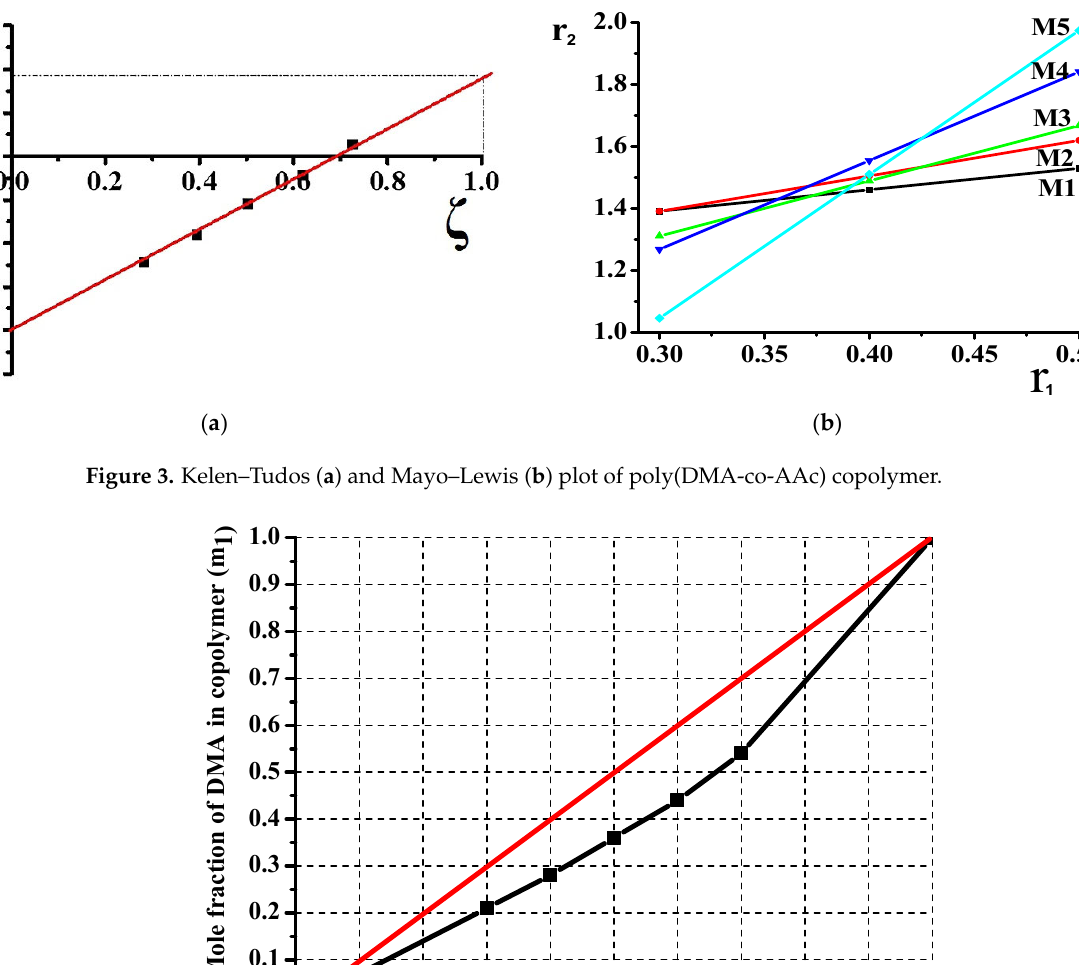
Figure 3. Kelen–Tudos ( a ) and Mayo–Lewis ( b ) plot of poly(DMA ‐ co ‐ AAc) copolymer. Table 2. Copolymer constants based on Fineman–Ross, inverted Fineman–Ross, Kelen–Tudos and Mayo–Lewis methods.